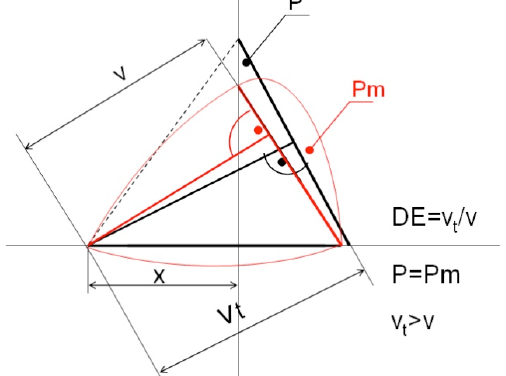
Fig. 13. Ultimate solution of FE measuring and calculating